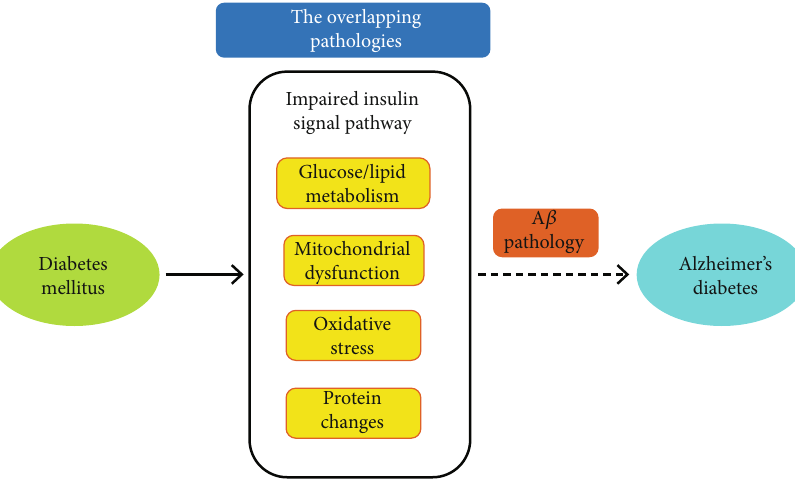
Figure 2: The overlapping pathology between diabetes mellitus (DM) and Alzheimer ’ s disease (AD). Due to many shared characteristics with impaired insulin signaling pathways, AD may be a metabolic disease. Metabolic changes including glucose/lipid metabolism, mitochondrial dysfunction, oxidative stress, and protein changes resulting from DM are associated with an impaired insulin signaling pathway. These metabolic factors could increase the prevalence of AD in diabetic patients, mainly by promoting A β